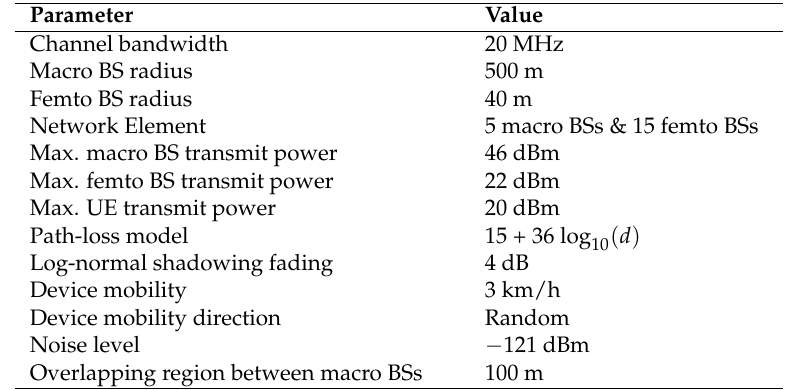
Table 3. Simulation parameters.